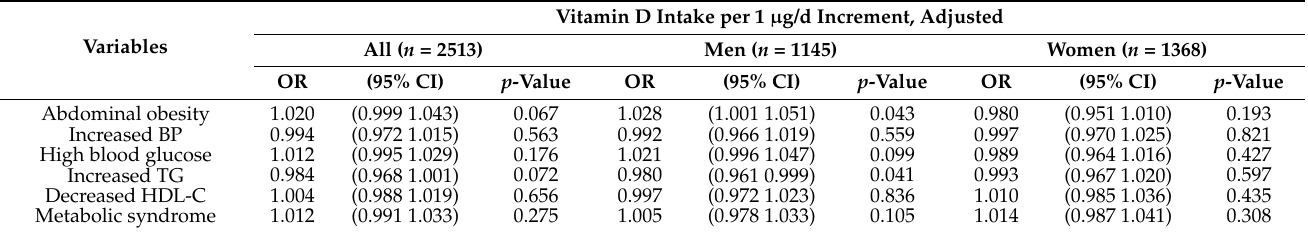
Table 6. Odds ratios for metabolic syndrome and its components by vitamin D